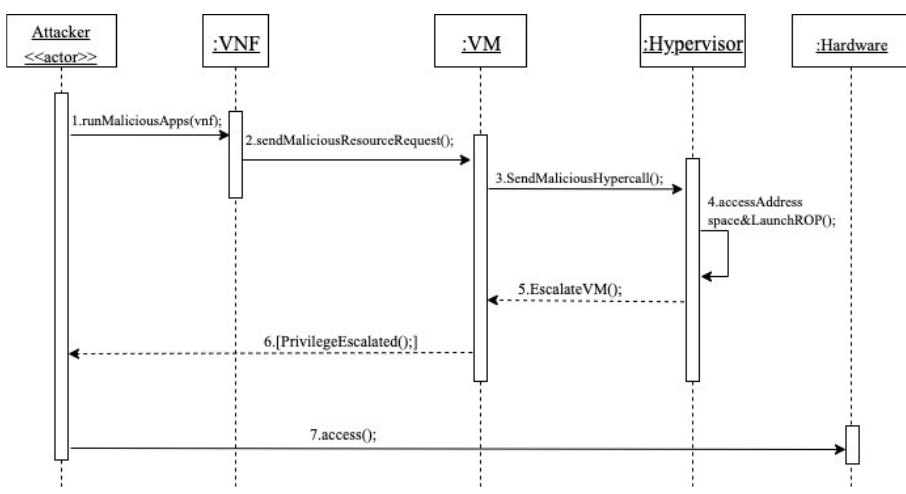
Figure 5. Sequence diagram for MC1 unauthorized access to hardware resources based on privilege escalation of an attacker’s VM [11] .